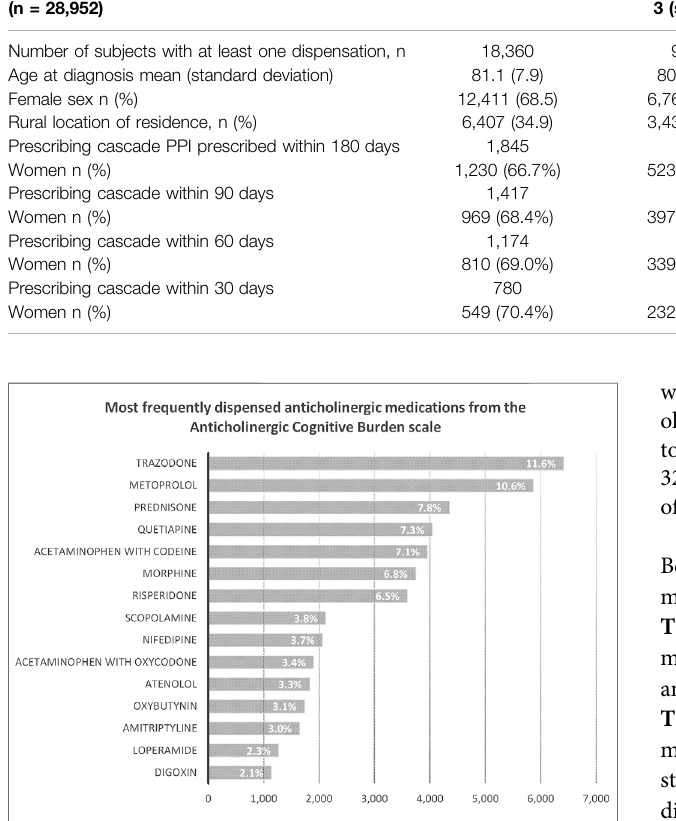
TABLE 1 | Anticholinergic and Proton Pump Inhibitor (PPI) Dispensation including Prescribing Cascade Occurrence in the cohort of older adults with dementia. Subjects (n = 28,952) Number of subjects with at least one dispensation, n